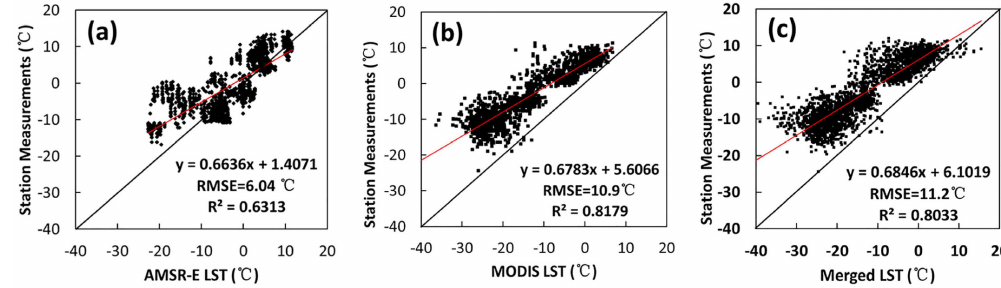
Figure 7. Comparison of the station measurements (0–5 cm soil temperatures) with the corresponding LSTs: ( a ) AMSR-E LST; ( b ) MODIS LST; and ( c ) merged LST for the seven